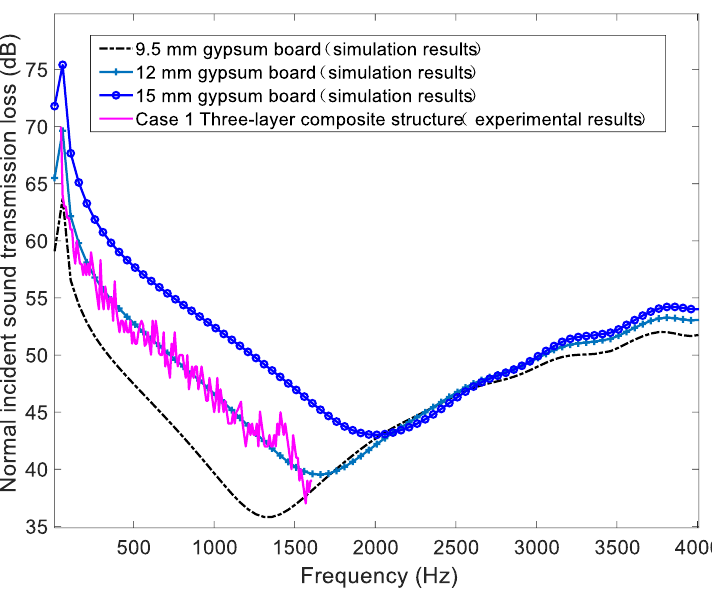
Figure 6. The STL spectrum of the composite partitions with the change of gypsum boards’ thickness.